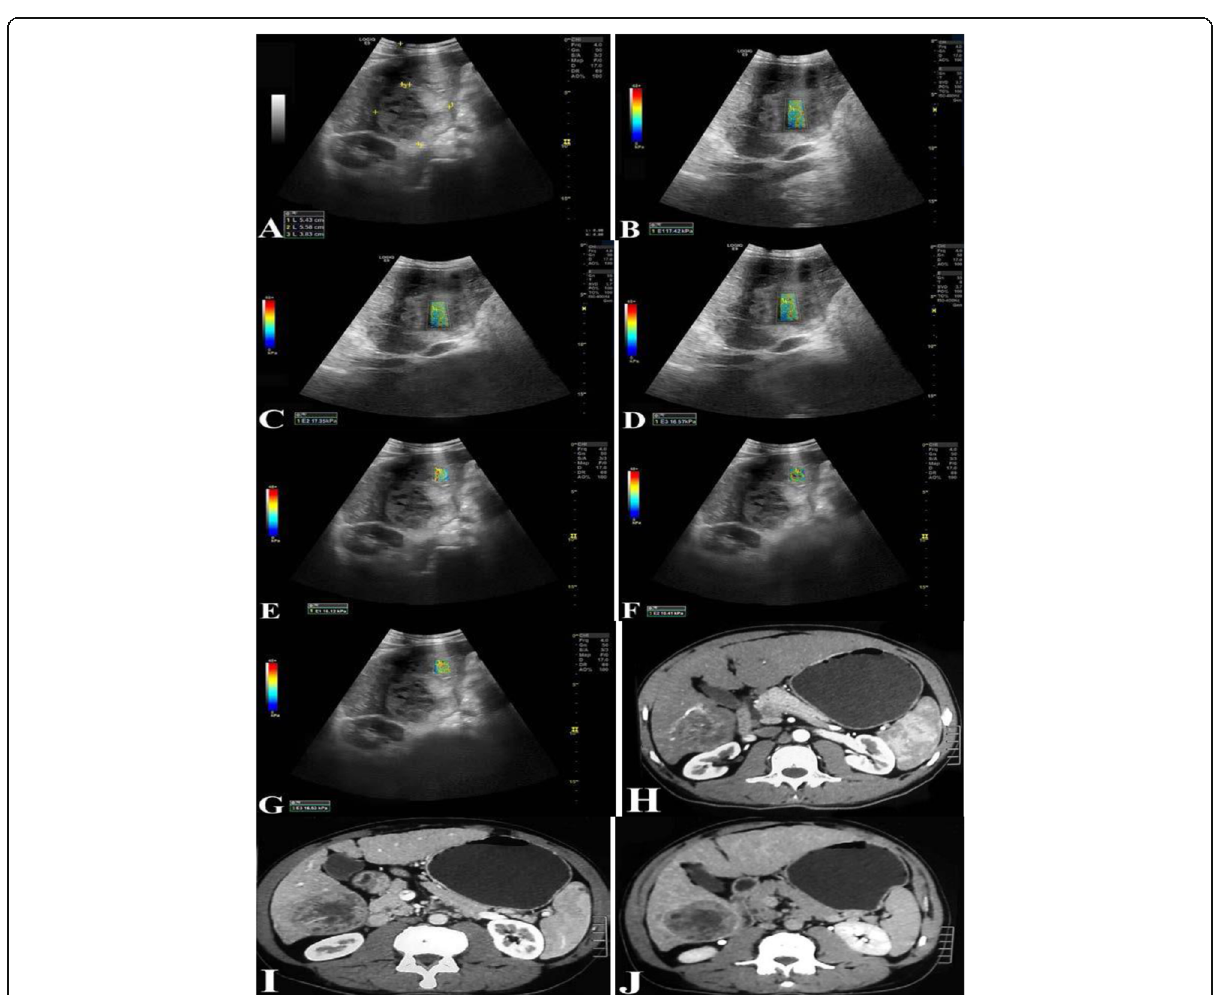
Fig. 4 Fifty-six years old male patient with chronic liver disease for follow-up abdominal ultrasound. Imaging findings: grey scale B-mode ultrasonography ( a ): normal sized cirrhotic liver with a well-defined hyperechoic focal lesion seen in segment VI measuring 5.4 × 5.5 cm with 3.8 cm depth from the skin. ϖ Color-coded shear wave sono-elastography: the lesion ( b , c , d ) and the parenchyma ( e , f , g ) showed mixed color with red foci. ϖ Shear wave sono-elastography stiffness values of the focal lesion: E1 = 17.42 kPa ( b ), E2 = 17.35 kPa ( c ), and E3 = 16.57 kPa ( d ). Calculated average stiffness value of the lesion = 17.11 kPa. ϖ Shear wave sono-elastography stiffness values of the parenchyma: E1 = 16.12 kPa ( e ), E2 = 16.41 kPa ( f ), and E3 = 16.53 kPa ( g ). Calculated average stiffness value of the parenchyma = 16.35 kPa. (cid:129) Lesion/parenchyma stiffness ratio = 1.04. ϖ Axial contrast enhanced triphasic CT study (arterial ( h ), portal ( i ), delayed ( j )): average size cirrhotic liver with a well-defined